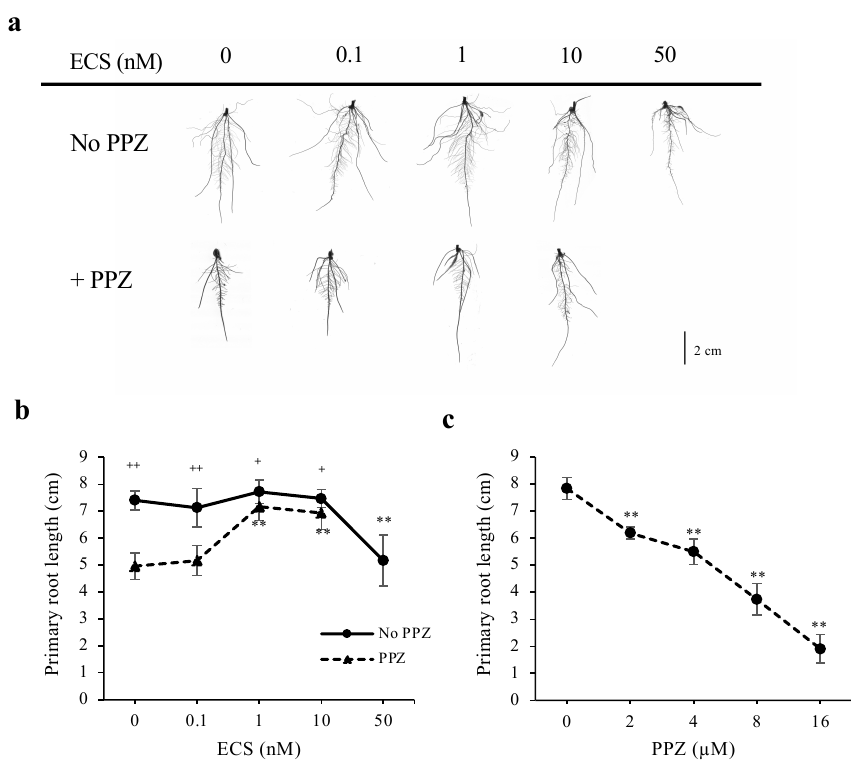
Figure 1. Effect of ECS and PPZ treatments on rice root growth. Root phenotypes of rice seedlings grown for 5 d under different concentrations of ECS or PPZ or combination of ECS and PPZ (4 µ M). ( a ) Representative images of roots grown under different treatments. Scale bar = 2 cm. ( b , c ) Quan- tification of primary root length. Data are means ± SD ( n = 10 biological replicates). Significant differences between the treatment and the mock control are indicated by ** for p < 0.001. Significant differences between PPZ and no PPZ (with the same ECS concentration) are indicated by + and ++ for p < 0.05 and 0.001,